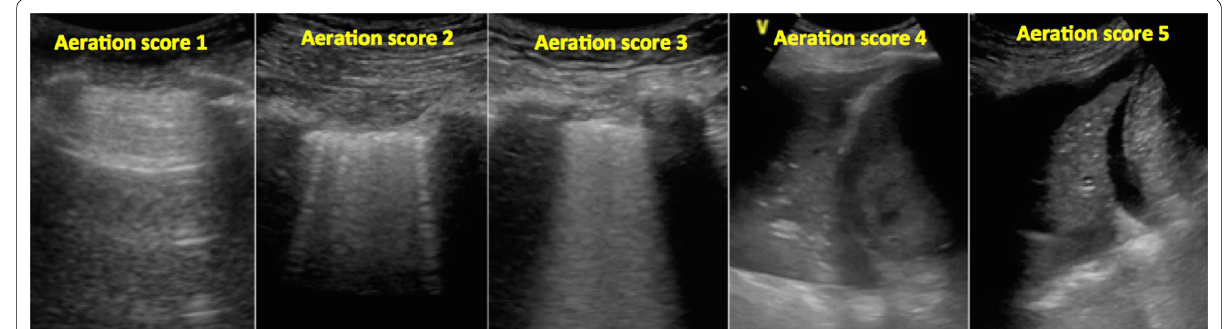
Fig. 6 Lung ultrasound aeration scoring. The pattern and the extent of aeration defect is quantified as follows: A normally aerated or fewer than 3 B-lines scored 1; multiple discrete B-lines scored 2; multiple and fused B-lines scored 3; unaerated consolidated lung scored 4; unaerated consolida- tion with pleural effusion scored 5. Hence, the maximum score for each half was 5 and the maximum score for the posterior zone was 5